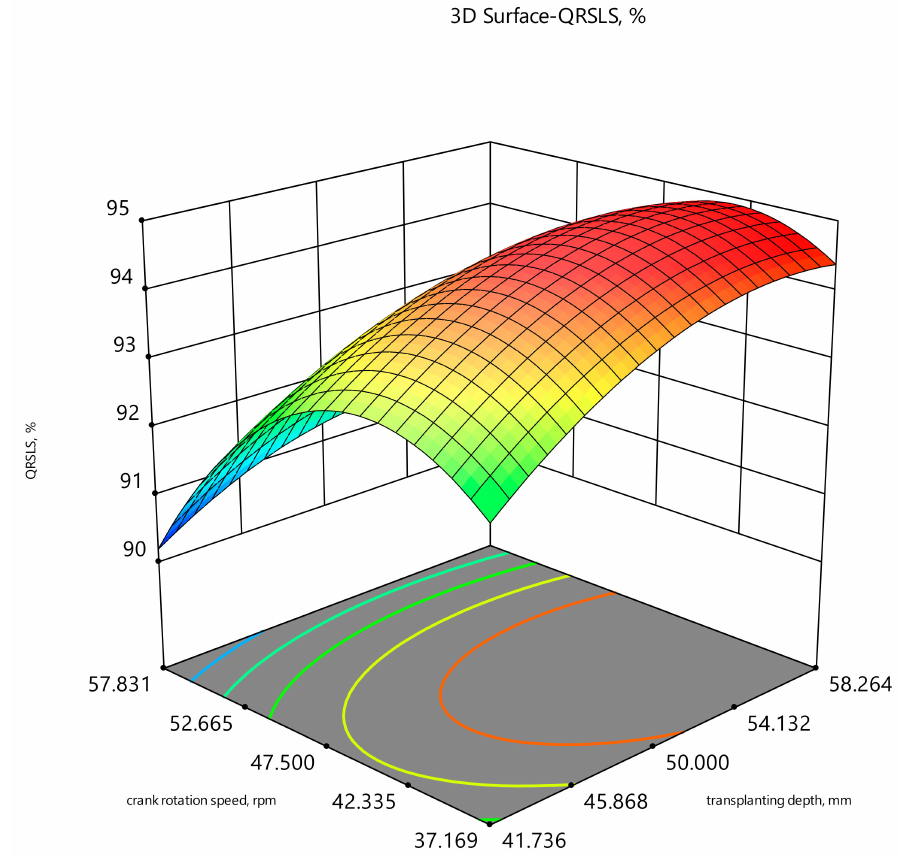
Figure 15. The interaction of transplanting depth and crank rotation speed on